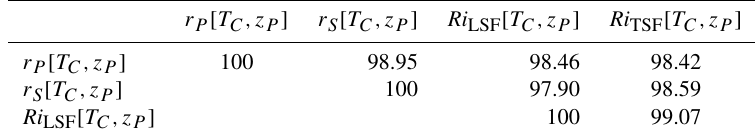
Figure 13. (a) Richardson number estimates from T C , u , v , and z P using the respective least squares fitting (LSF) and Theil–Sen fitting (TSF) methods. The thick black line shows the threshold Ri = 0 . 25. The two inferred turbulence indexes are shown (thick green lines at the top of the plot). (b) Histograms of the two Richardson number estimates. Table 6. Percentage of identical turbulence detections from four turbulence index using ( T C , z P ) for flight 02_STR2.